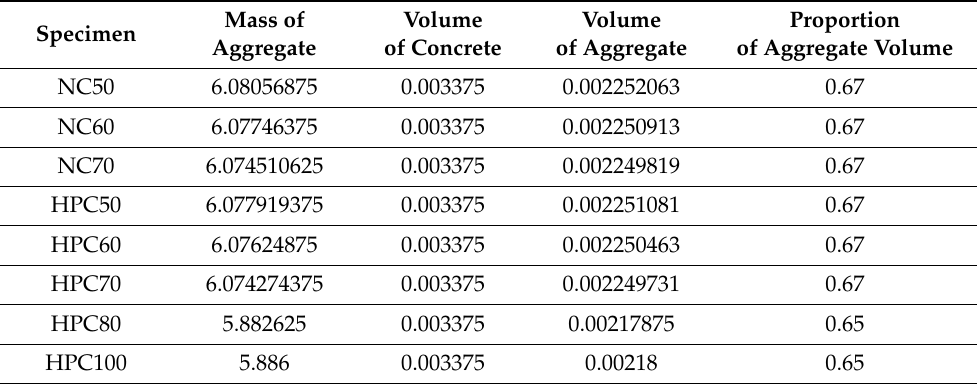
Table 3. Proportion of aggregate volume to concrete for each strength grade. Specimen